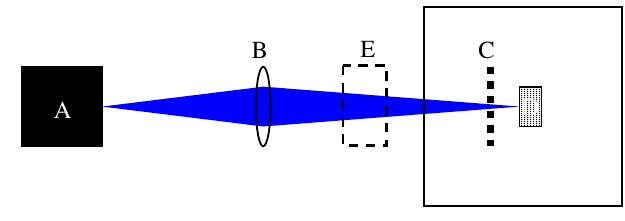
FIG. 6. (Color) Lead cathode surface morphology prior to laser cleaning: (a) arc-deposited, (b) sputtered, (c) evaporated, (d) polished solid